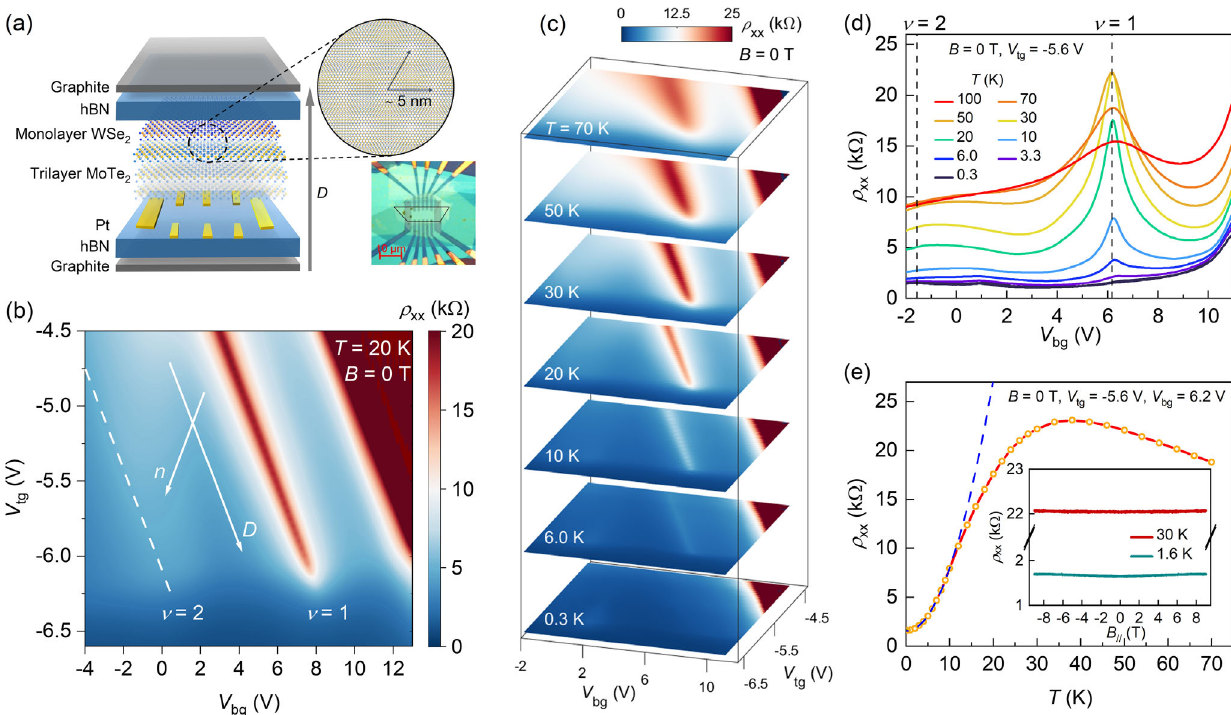
FIG. 1. Device structure and Pomeranchuk effect in 3 L-MoTe 2 = WSe 2 moir´e superlattices. (a) Schematic (left) and optical micrograph (lower right) of the device with double graphite gates. The conduction channel of the device is outlined by the black curves in the micrograph. The scale bar is 10 μ m. (b) 2D longitudinal resistance ρ as a function of top and bottom gate voltages ( V and V , xx tg bg respectively) at T ¼ 20 K and zero magnetic field. An obvious resistivity peak is observed at half filling ν ¼ 1 . The dashed line marks the expected position of full filling ν ¼ 2 . The two arrows denote the directions of increasing D and n , respectively. (c) Evolution of ρ xx as a function of T . Each color map plane shows the ρ versus V and V at a fixed T . (d) The ρ as a function of bottom gate voltage at xx xx tg bg ¼ − 5 . 6 V at different temperatures. Two dashed lines indicate the position of ν ¼ 1 and ν ¼ 2 , respectively. a fixed top gate voltage V tg ¼ − 5 . 6 V and V ¼ 6 . 2 V ( ν ¼ 1 and (e) Temperature dependence and in-plane magnetic field dependence (inset) of ρ at V xx tg bg ð T Þ follows a Fermi liquid behavior AT 2 þ ρ D ¼ 1 . 313 V nm − 1 ). At low temperatures ( T < 10 K), ρ 0 (blue dashed xx